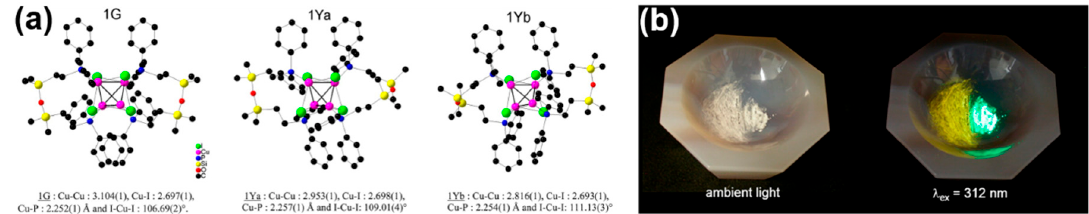
Figure 8. ( a ) Molecular structure of clusters 1G and 1Y and the mean of selected bond lengths. Hydrogen atoms have been omitted for clarity. ( b ) Photos of the ground (left) and intact (right) crystalline powder of 1G under ambient light and under UV irradiation at 312 nm (UV lamp) at room temperature. Reprinted with permission from Ref. [46]. Copyright (2014) American Chemical Society.